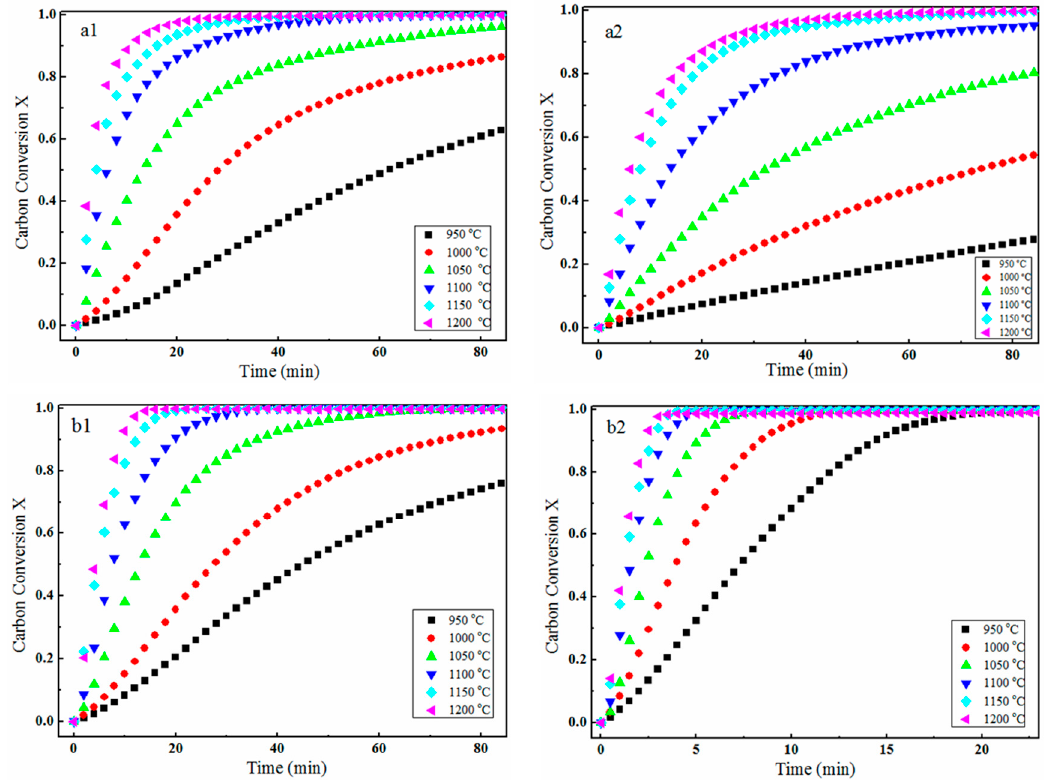
Figure 1. The profiles of carbon conversion vs. gasification time, in response to variation of the temperatures ( a1 : RC-I, b1 : RC-II; a2: AFC-I; b2: AFC-II). Processes 2020 , 8 , 1367